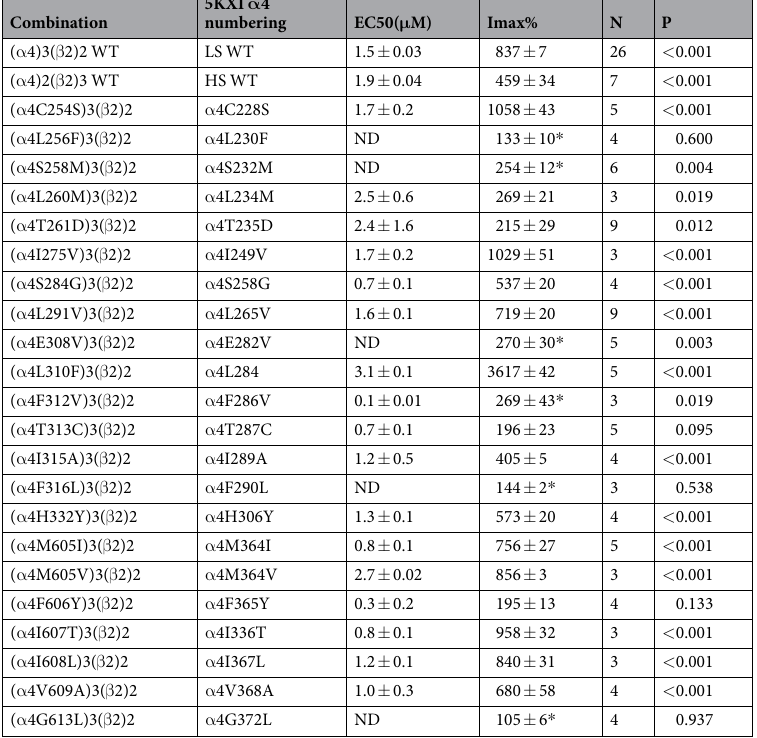
Table 2. LY2087101modulation of WT and mutants ( α 4)3( β 2)2 nAChRs. Current responses to 10 µ M ACh alone or in the presence of increasing concentrations of LY2087101 were recorded from oocytes expressing WT and mutants ( α 4)3( β 2)2 nAChRs. For each application, peak current amplitude was quantified and normalized to peak current amplitude elicited by 10 µ M ACh alone within the same recording run. Replicas from the same oocyte were averaged, and for each LY2087101 concentration (Average ± SE) of data from several oocytes (N) were plotted (Fig. 6) and fit to equation 1. The probability (P) that an I max differs from no potentiation ( I max = 100) was analyzed using a one-way analysis of variance with the Holm-Sidak Test. Curve fitting, parameters calculation, and statistics were performed in SigmaPlot 11 (Systat Software Inc.). * Values are not derived from curve fitting, they represent the maximum I max seen for that mutant at any concentration up to 10 µ M LY2087101. ND = not